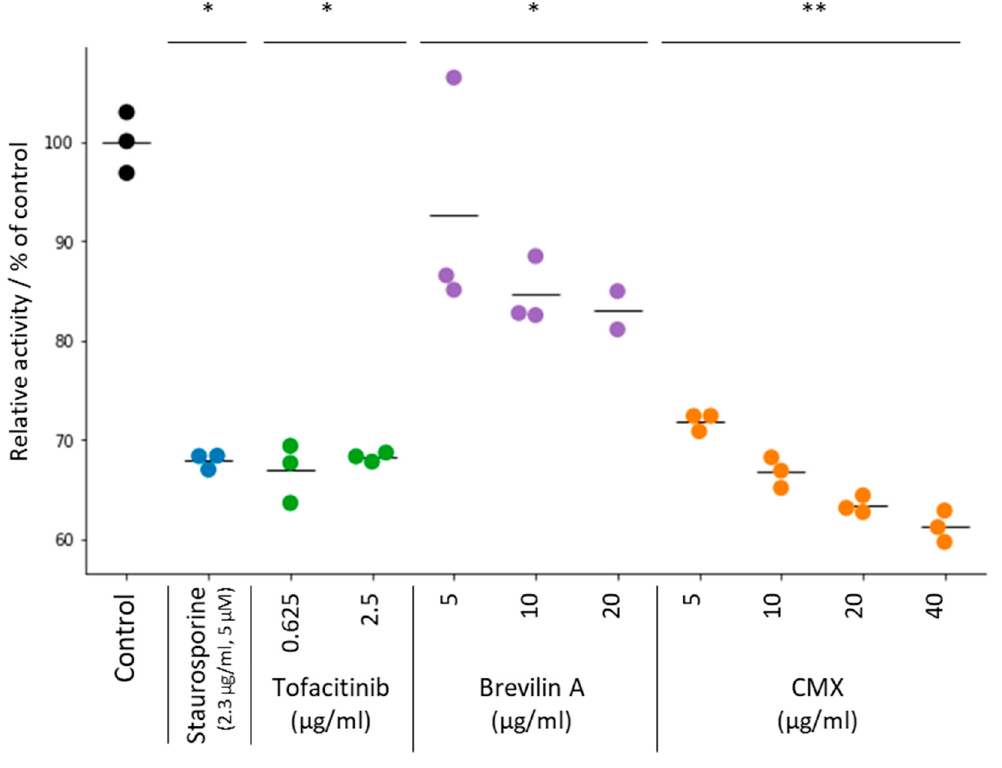
Figure 4. Comparison of inhibitory e ff ect of staurosporine, tofacitinib, and CMX on JAK3 kinase. * p < 0.05 versus control group; ** p < 0.01 versus control group; statistical significance was